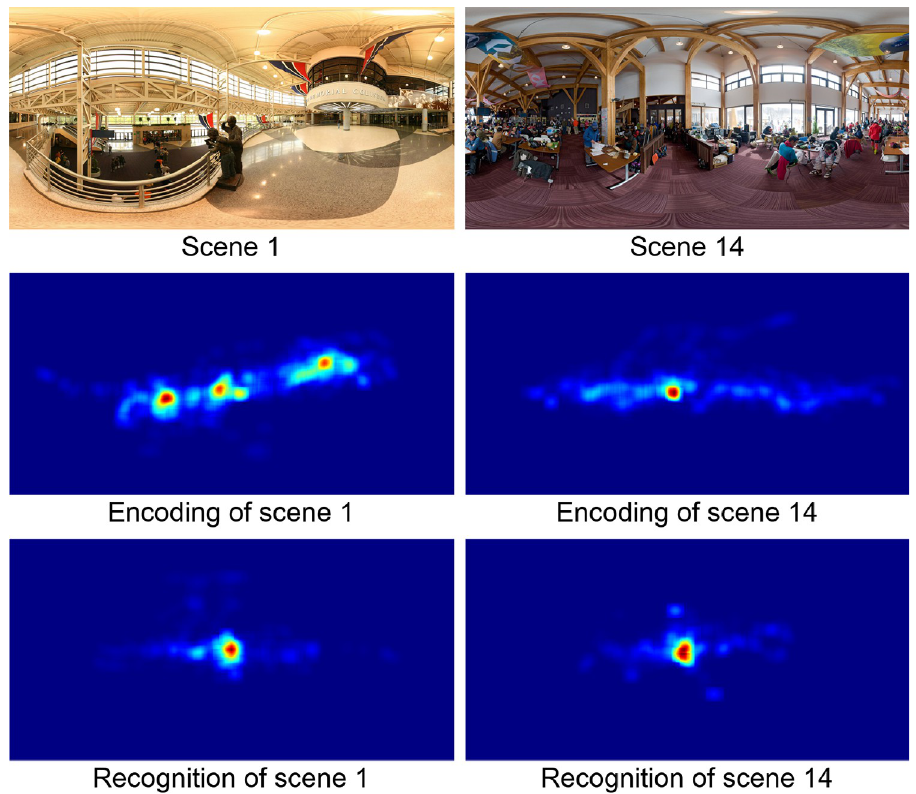
Fig 4. Head position heatmaps for two sample scenes. The original images are shown in the top panels, the heatmaps of the encoding head positions in the middle panels, and the heatmaps of the recognition head positions in the bottom panels. The heatmaps are color-coded, with red indicating the strongest values and blue indicating the weakest values.